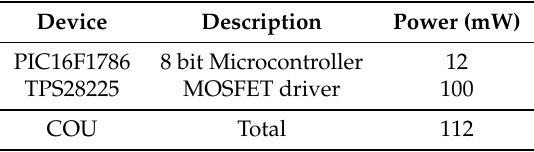
Table 8. COU power dissipation